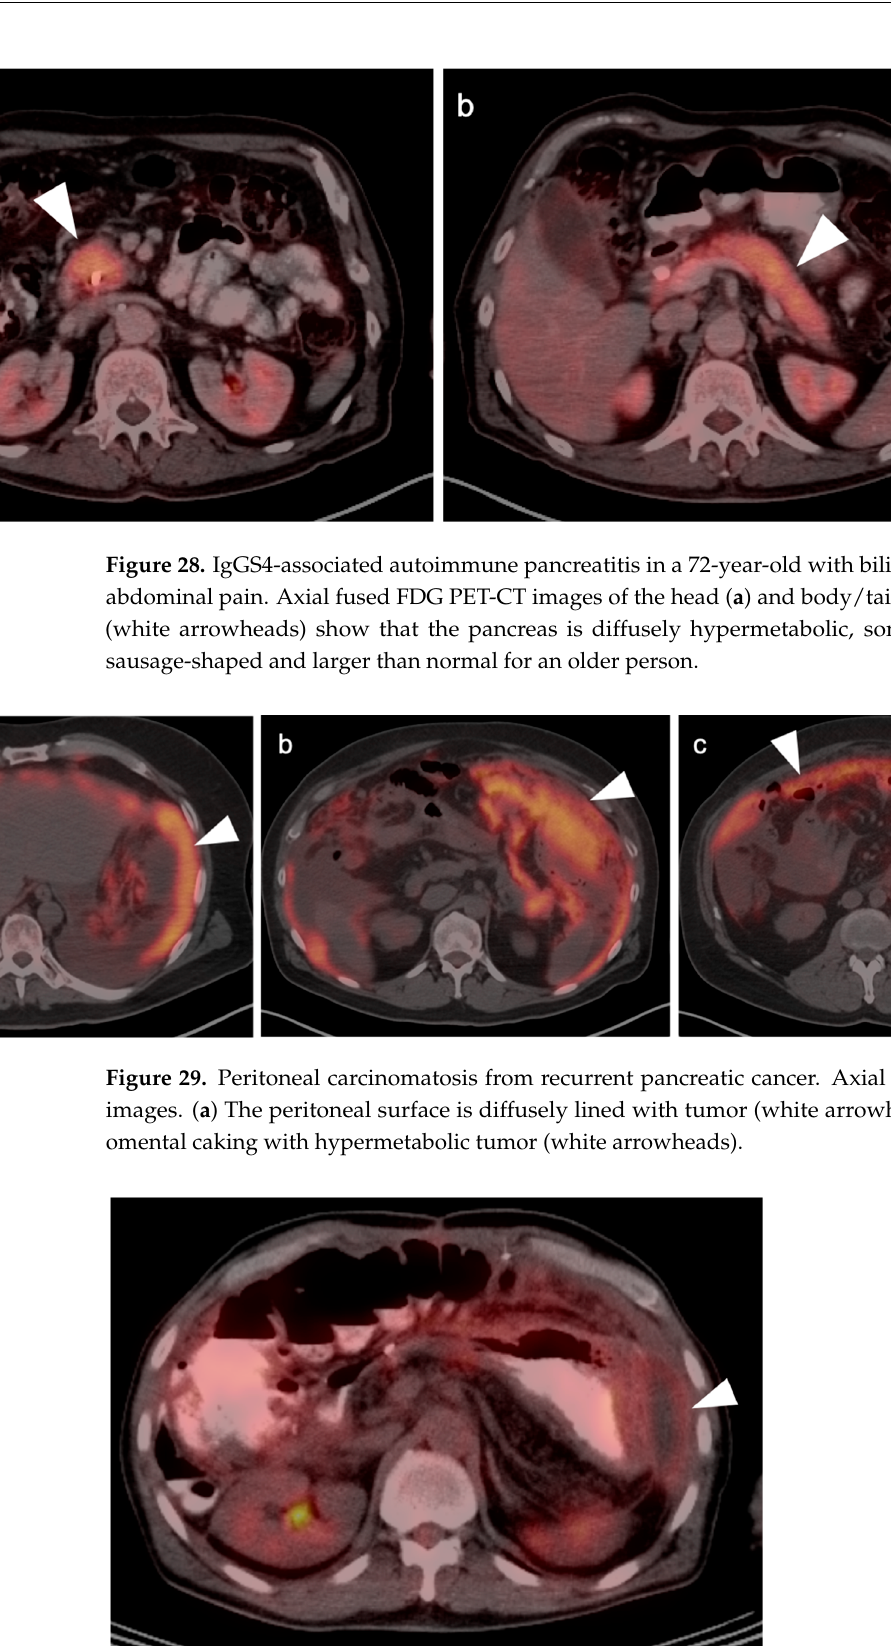
21 of 35 Figure 27. Highly variable appearance of highly mucinous pancreatic neoplasms on FDG PET-CT: ( a – e ). ( a , b ) Mucinous adenocarcinoma of the body of the pancreas is low attenuation on axial con-